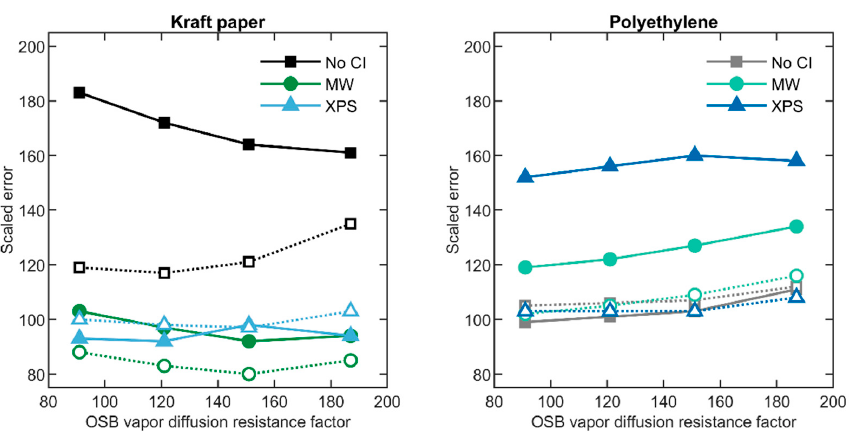
Figure 24. Scaled error for OSB vapor diffusion resistance factor values. Left subfigure plots kraft walls while right subfigure plots poly walls. Solid symbols represent North wall results, while open symbols South wall results.